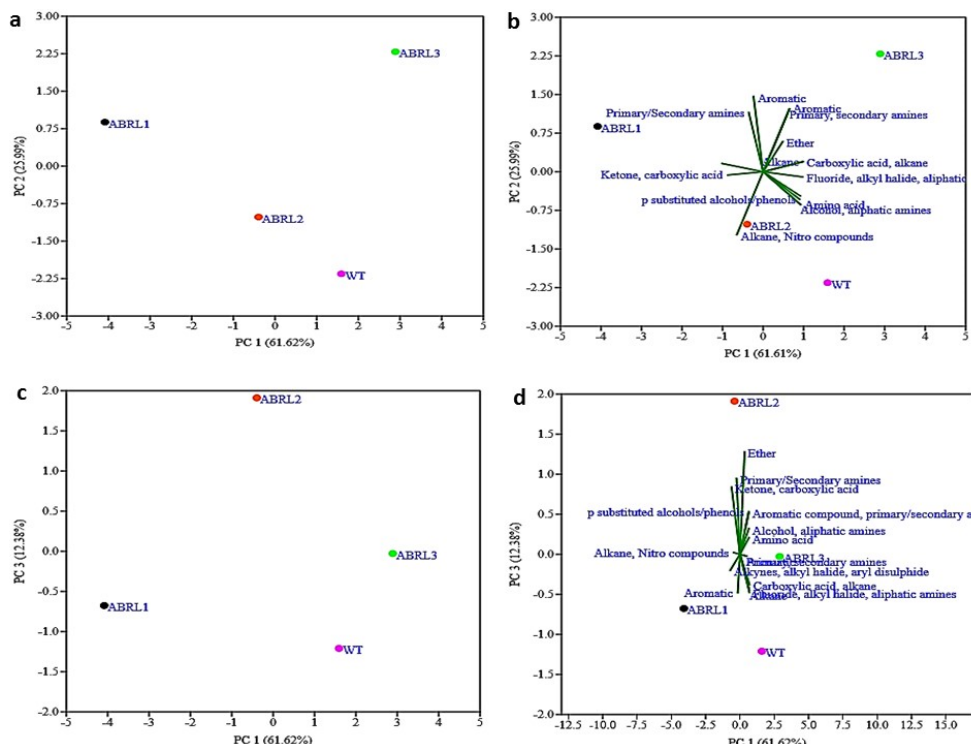
Figure 4. Principal component analysis (PCA) of functional groups detected through FTIR ( a ) scatter plot of samples in PC 1 vs. PC 2 ( b ) scatter plot of functional groups in PC 1 vs. PC 2 (Biplot) ( c ) scatter plot of PC 1. vs. PC 3 ( d ) scatter plot of functional groups in PC 1 vs. PC 3 (Biplot).